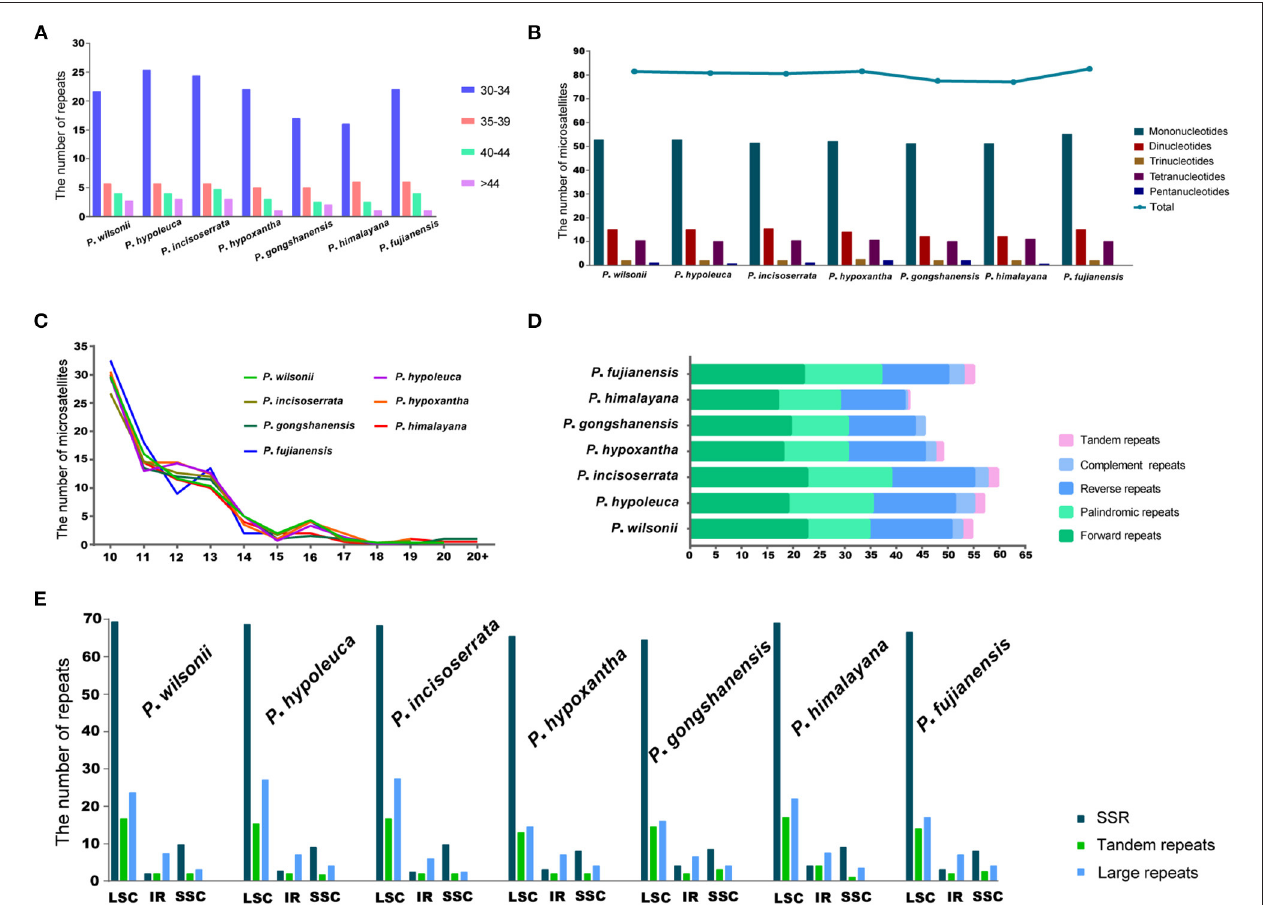
FIGURE 6 | Analyses of simple sequence repeats (SSRs) and repeated sequences in plastomes of Maddenia species. (A) Frequency of four repeats by length; (B) Number of five repeat types; (C) Frequency of microsatellites by length; (D) Numbers of five different types of repeats; (E) Number of all repeats by